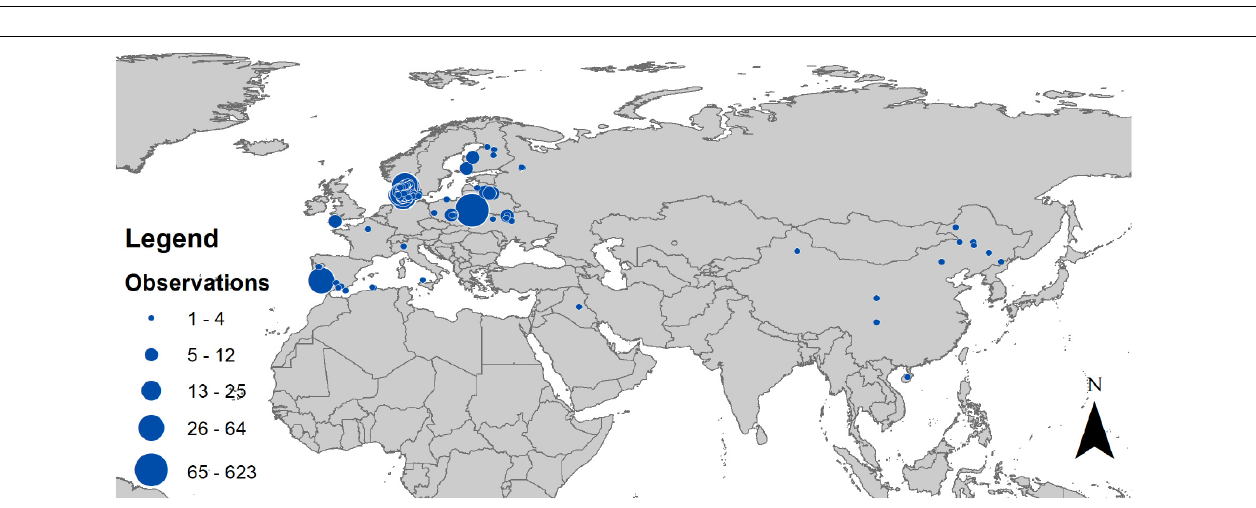
FIGURE 3 | Map of the distribution of sampling sites for insects with cars in Europe and Asia. The size of circles is proportional to the number of samples. The map was created using ArcGIS 10.1 (ESRI, 2012).